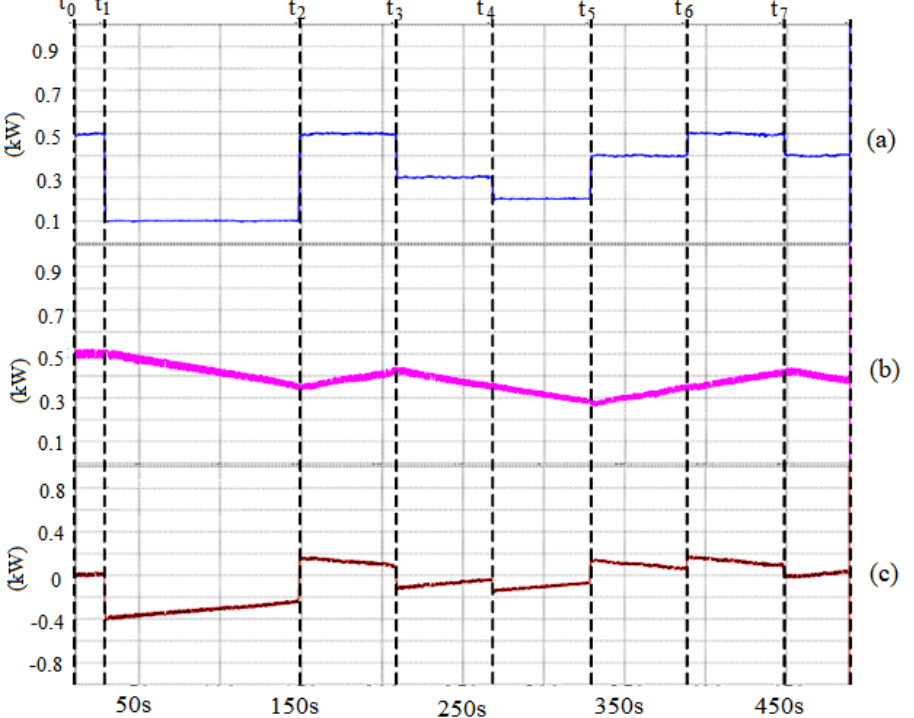
Figure 19. Experimental results when the smoothing mechanism is activated, ( a ) output power of the solar simulator, ( b ) output power of the PPGS, ( c ) power of battery pack. solar simulator, ( b ) output power of the PPGS, ( c ) power of battery